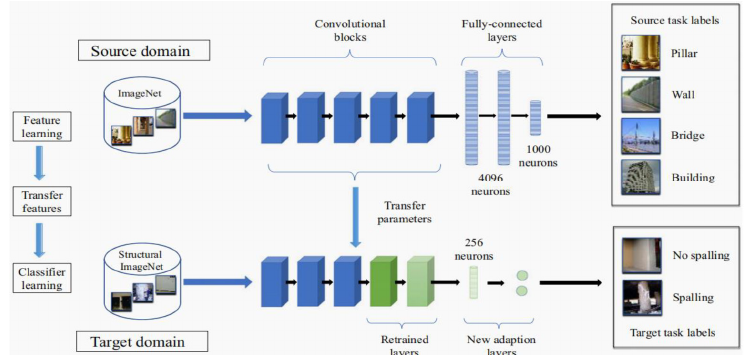
Figure 17. Learning based damage detection.